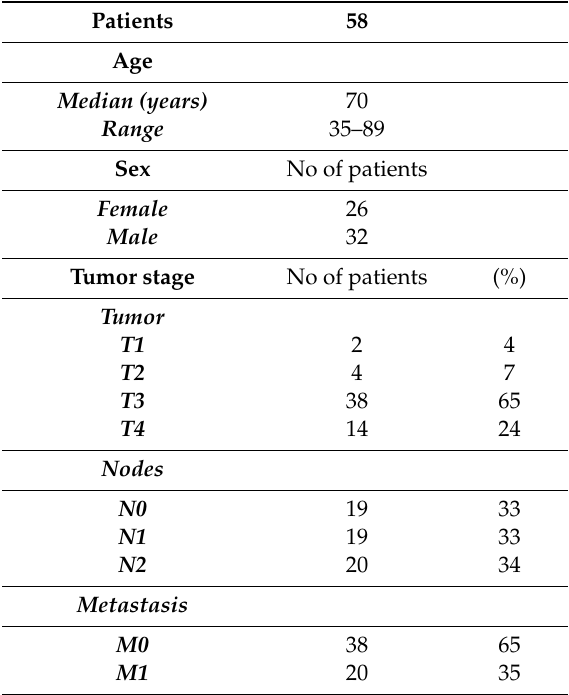
Table 1. Patients’ baseline characteristics.